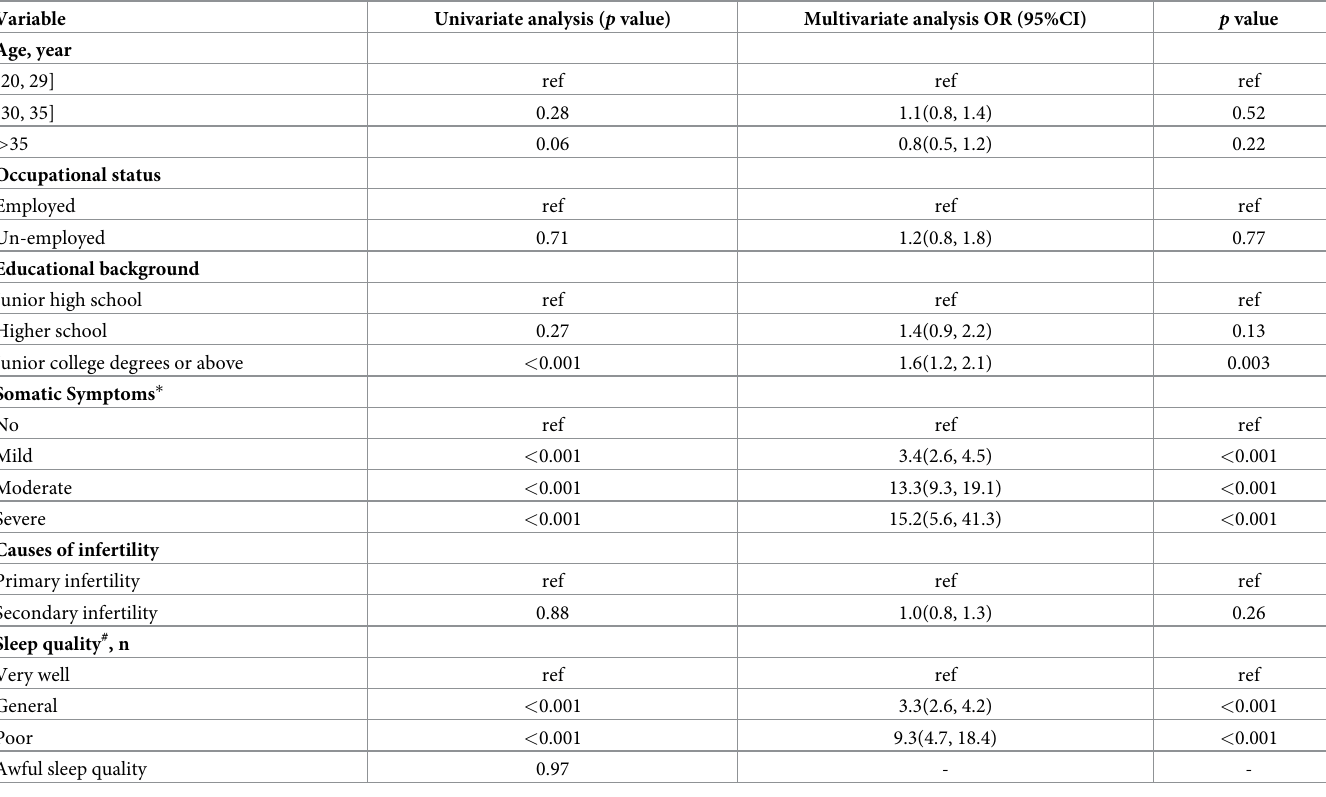
Table 2. Univariate analysis and multivariate logistic regression analysis of the anxiety in infertile